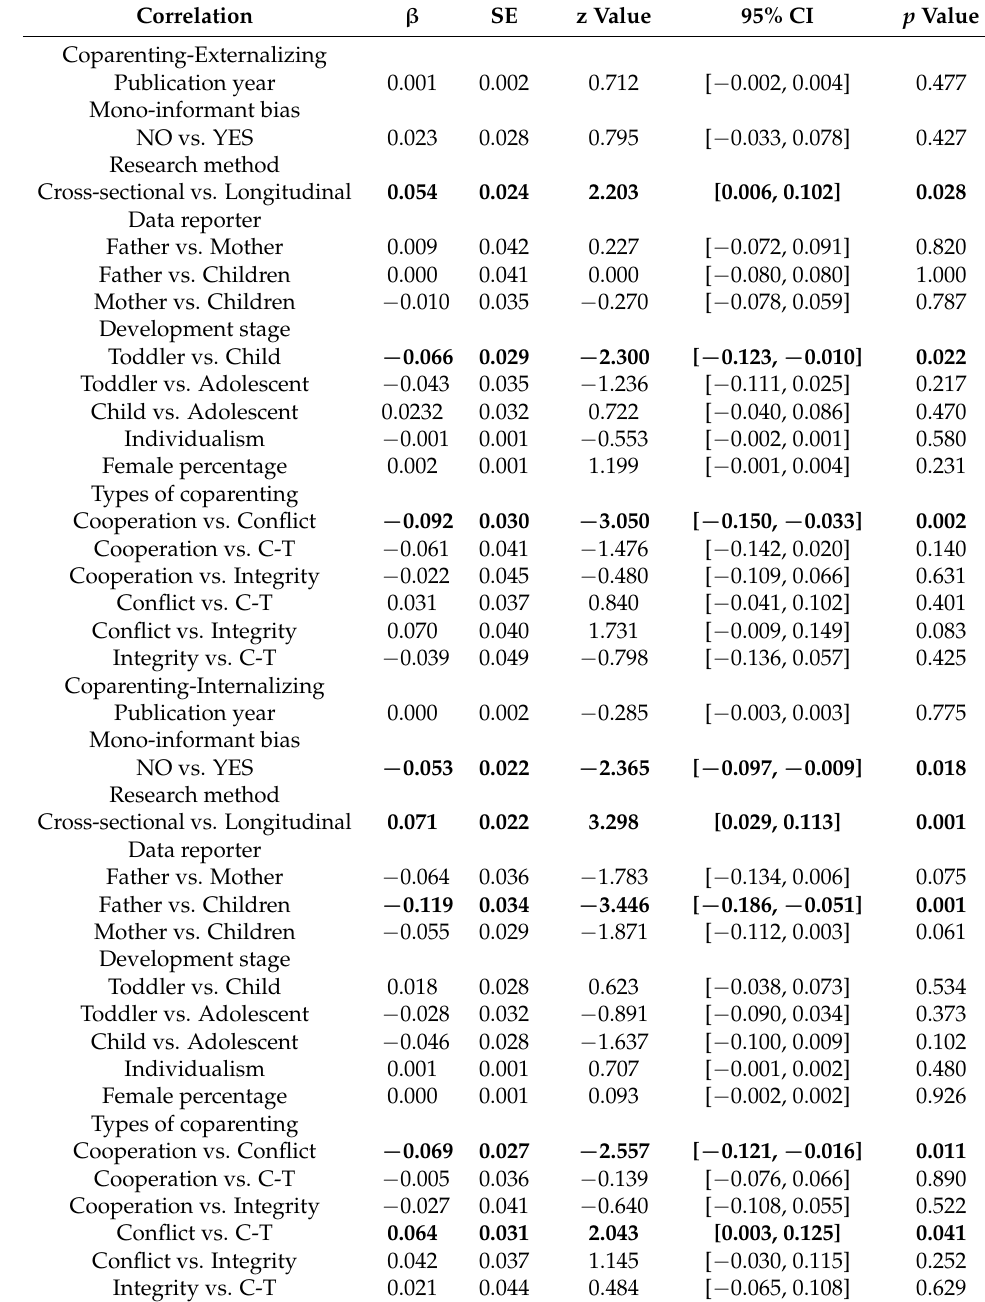
Table 2. Moderations on the correlation between coparenting and externalizing and internalizing